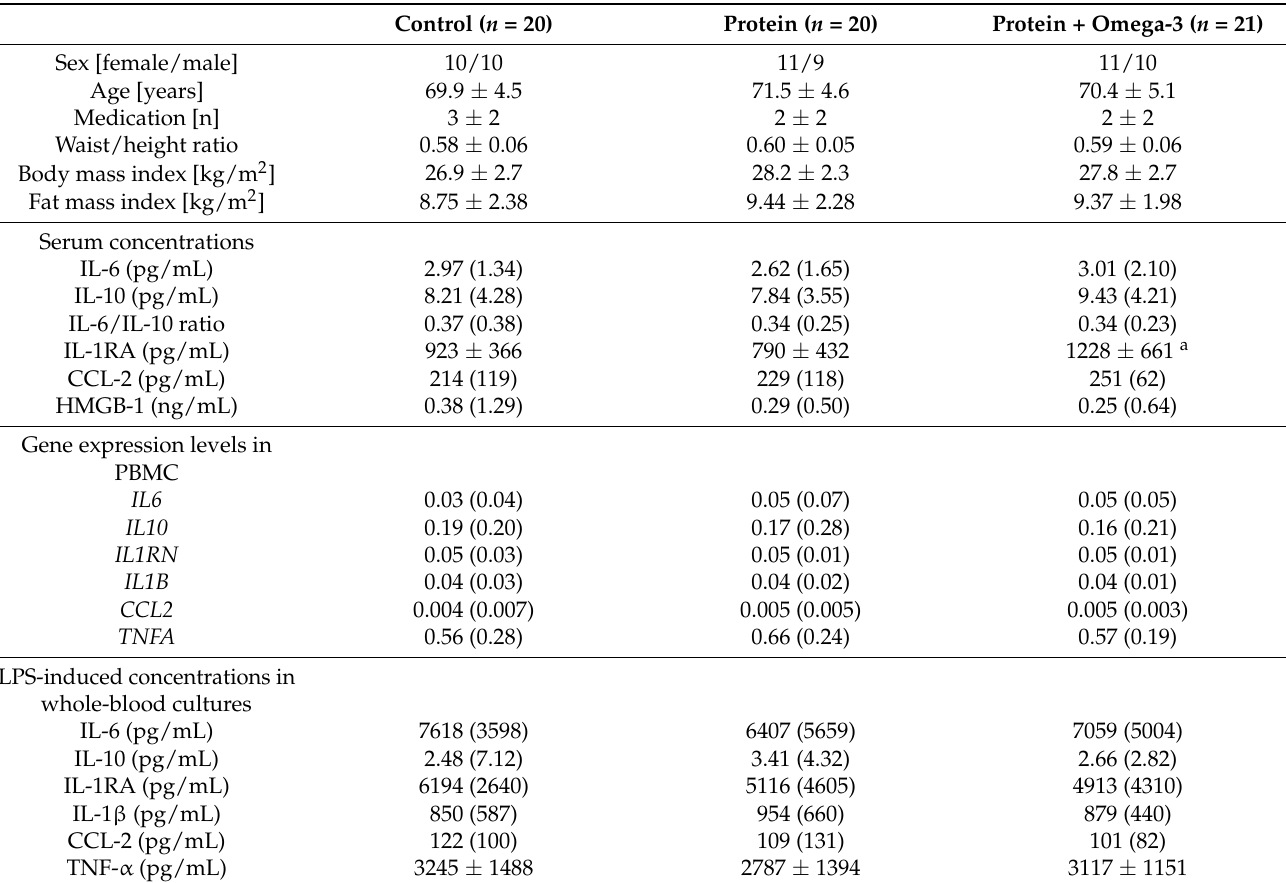
Table 1. Baseline characteristics and inflammatory markers, displayed for control, high-protein (protein), and high-protein, omega-3 enriched (protein + omega-3)